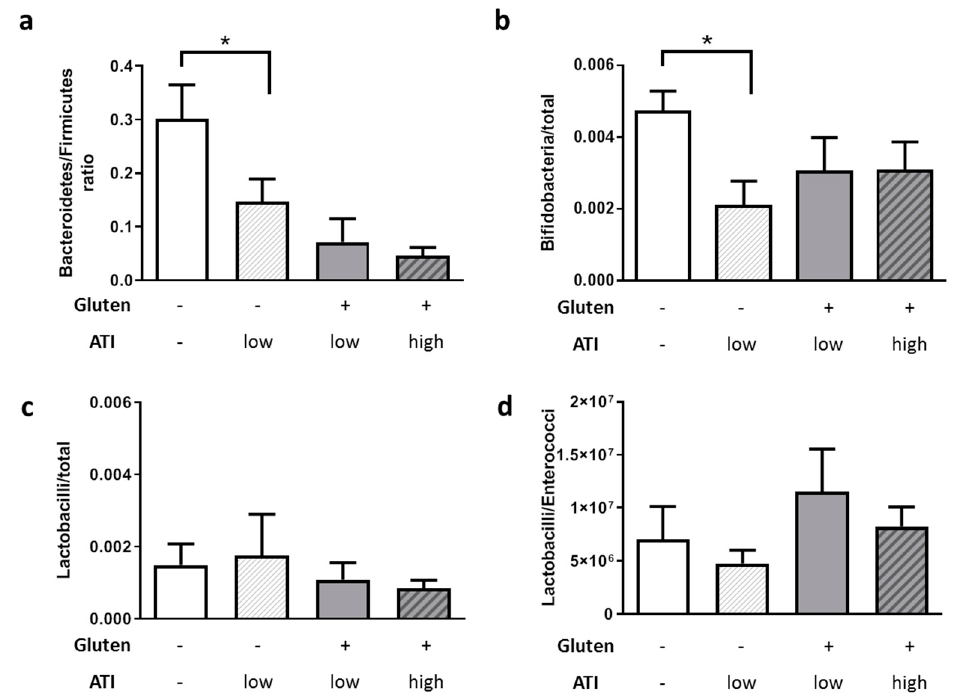
Figure 4. Fecal microbial communities in animals are changed by nutritional ATIs. Fecal samples were collected during sacrifice and subjected to quantitative PCR-based analysis. ( a ) Ratio of Bacteroidetes to Firmicutes. ( b ) Bifidobacteria in relation to total bacterial cell counts. ( c ) Lactobacilli in relation to total bacterial cell counts. ( d ) Ratio of Lactobacilli to Enterococci. All data are given as mean + SEM. Statistical analysis was performed by One Way ANOVA (Sidak’s multiple comparisons test; *, p < 0.05; n ≥ 6 per group).